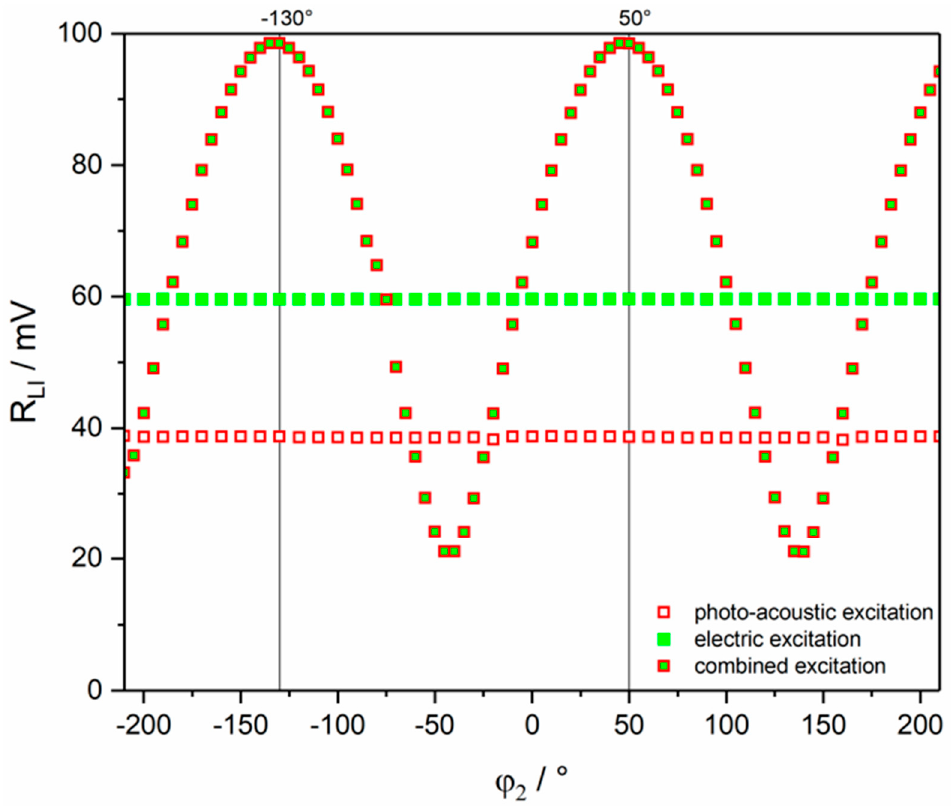
Figure 1. Generated signal amplitude at the lock-in-amplifier for photoacoustic excitation (open red squares), electrical excitation (solid green squares), and simultaneous excitation (green filled red squares). The latter depends on the phase between the two driving forces.